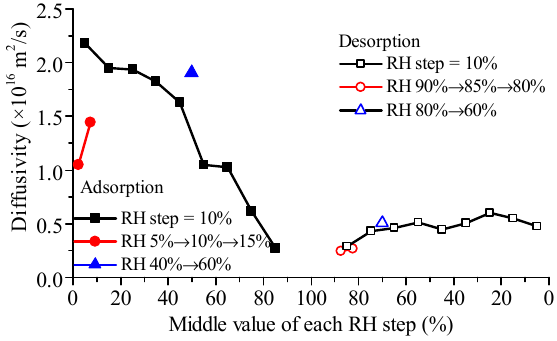
Figure 3. Water di ff usivities in glutinous rice fl our particles during adsorption and desorption with Figure 3. Water diffusivities in glutinous rice flour particles during adsorption and desorption with di ff erent RH step sizes obtained according to Fick’s second law. different RH step sizes obtained according to Fick’s second